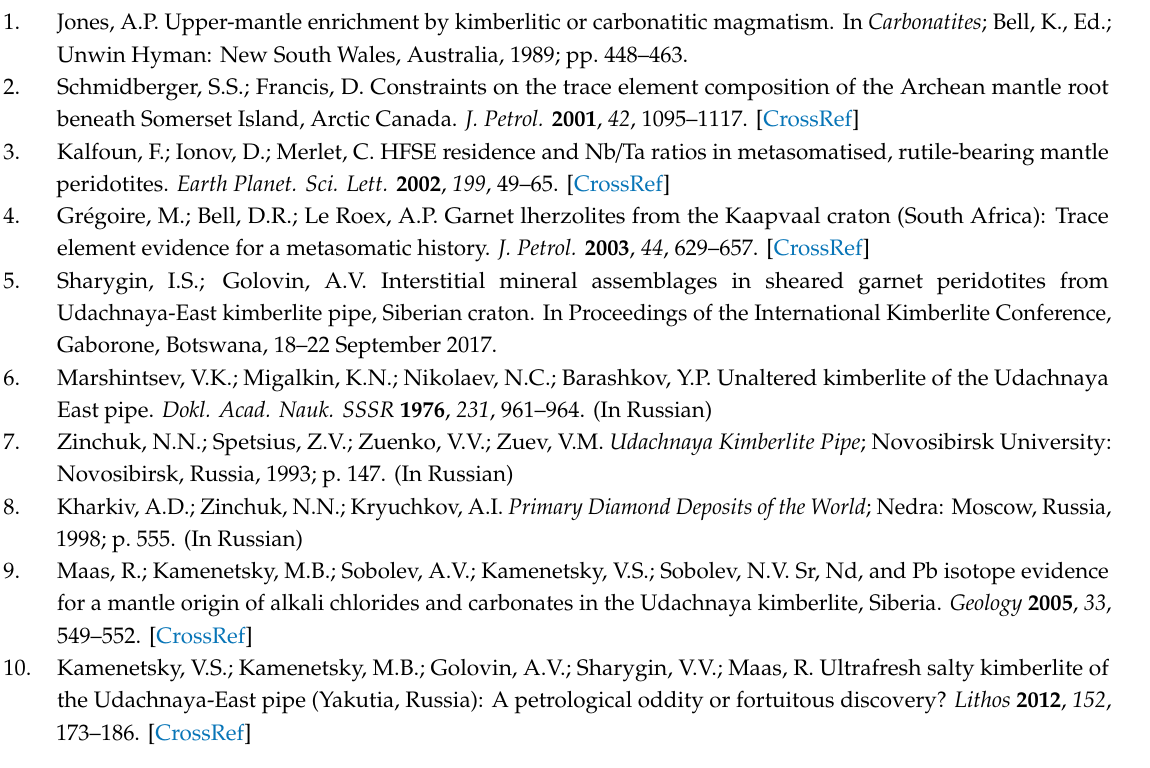
Table S1: EMP analyses of olivine. Table S2: Representative EMP analyses of phlogopite and tetraferriphlogopite. Table S3: Representative EMP analyses of amphibole-supergroup minerals. Table S4: Representative EMP analyses of ilmenite-group minerals. Table S5: Representative EMP analyses of spinel-group minerals. Table S6: Representative EMP analyses of LILE-bearing titanates. Table S7: Representative EMP analyses of sulfides in the crystallized melt